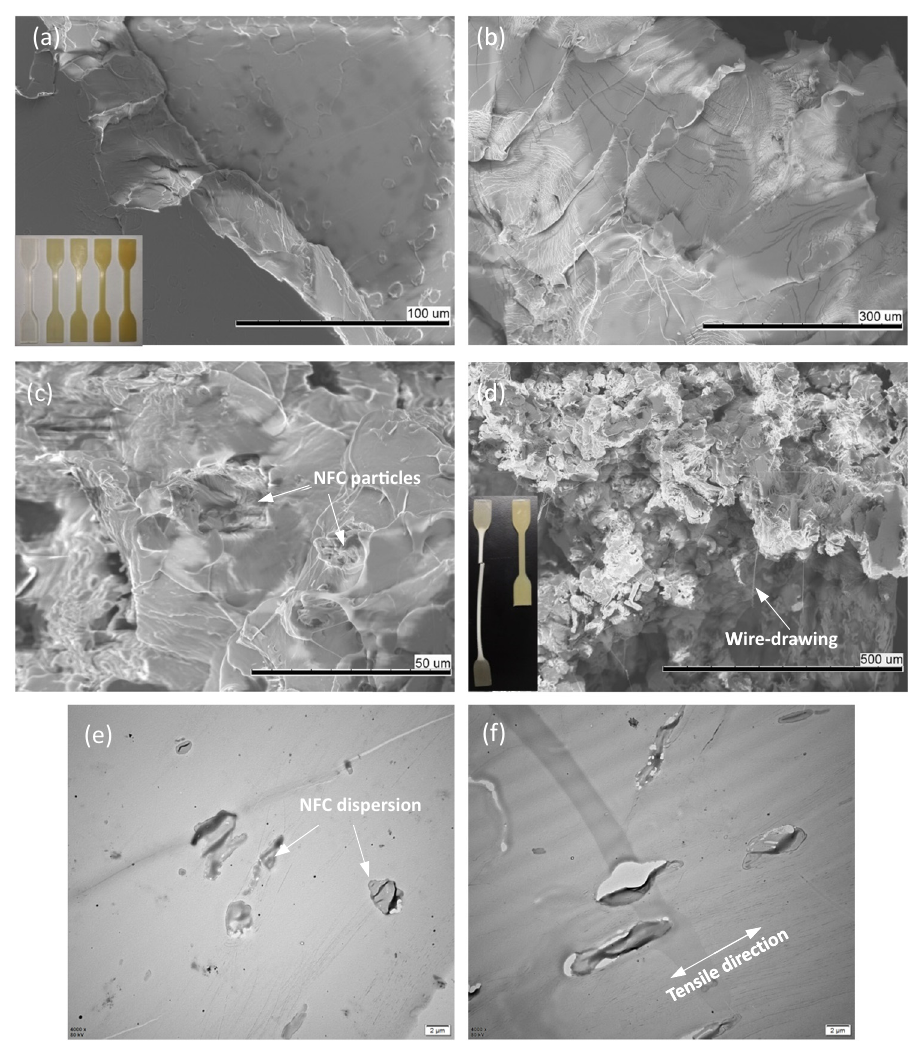
Figure 3: SEM images of tensile fractural surface of ( a ) pure PLA, ( b ) PLA with 15 wt% ATBC, ( c ) PLA composites with 15 wt% ATBC and 4 wt% NFC, ( d ) PLA composites with 20 wt% ATBC and 4 wt% NFC, ( e ) cross - sectional TEM image of PLA composites with 20 wt% ATBC and 4 wt% NFC, ( f ) vertical - sectional TEM image of PLA composites with 20 wt% ATBC and 4 wt% NFC after